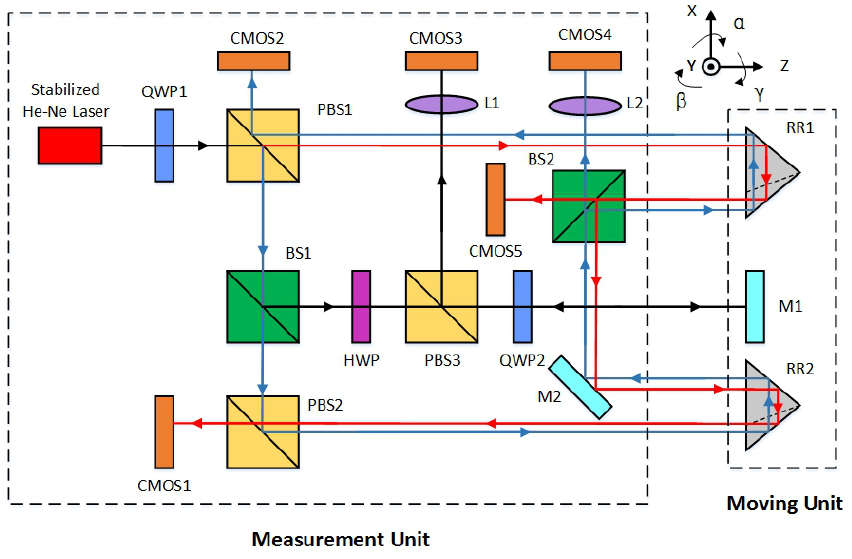
Figure 1. Schematic of the system measuring 5DOF motion